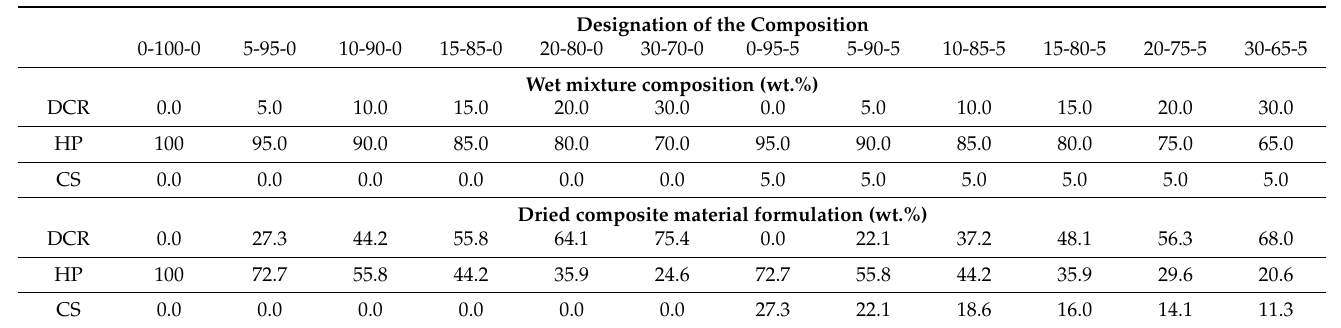
Table 2. The composition of block and granules in the raw mixture (wet) and after drying by wt.% (part I) [4].